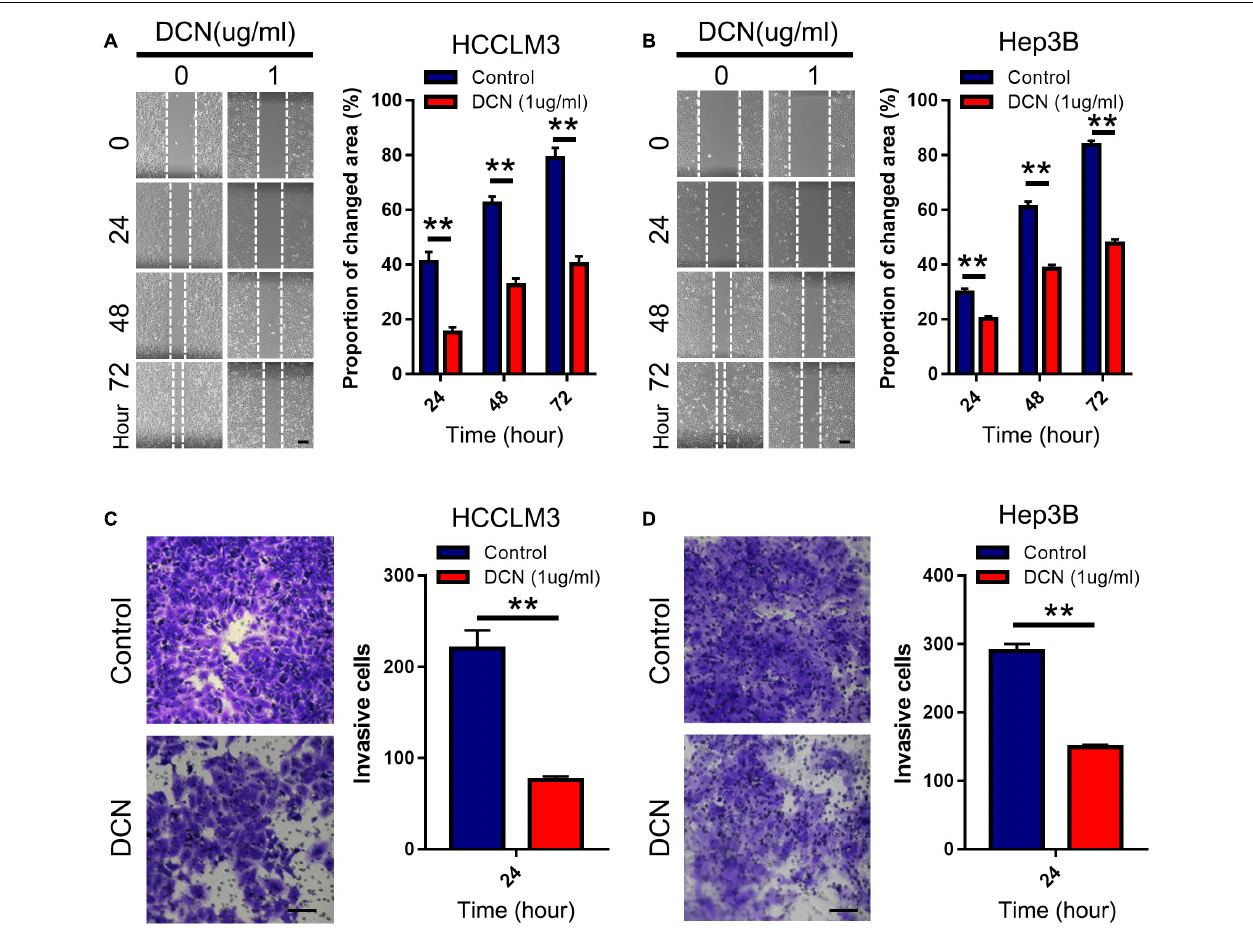
FIGURE 4 | DCN inhibits migration and invasion of HCC cell lines. (A,B) Wound-healing assays for HCCLM3 (A) , and Hep3B (B) cells treated with DCN (1 µ g/mL) or the negative control. Scale bars, 200 µ m. (C,D) Transwell assays for HCCLM3 (C) , and Hep3B (D) cells treated with DCN(1 µ g/mL) or the negative control. Scale bars, 100 µ m. Data presented as mean ± SEM. ** P < 0.01, Student’s t